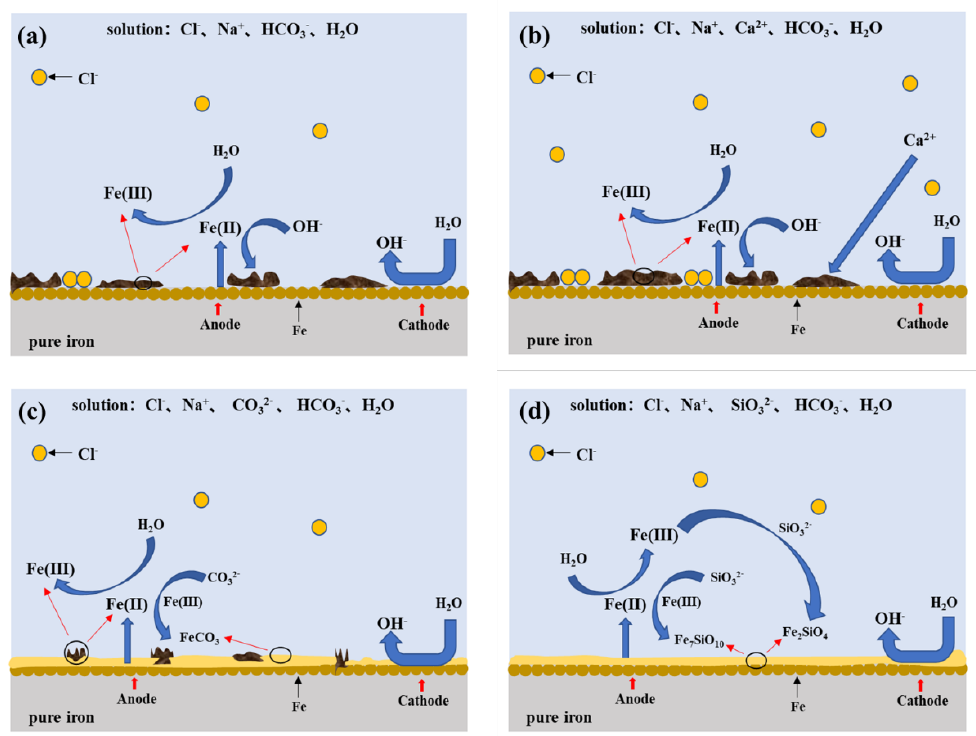
Figure 12. The mechanistic scheme of corrosion behavior of iron in simulated groundwaters. ( a ) SG; ( b ) SG + CaCl 2 ; ( c ) SG + Na 2 CO 3 ; ( d ) SG + Na 2 SiO 3 .